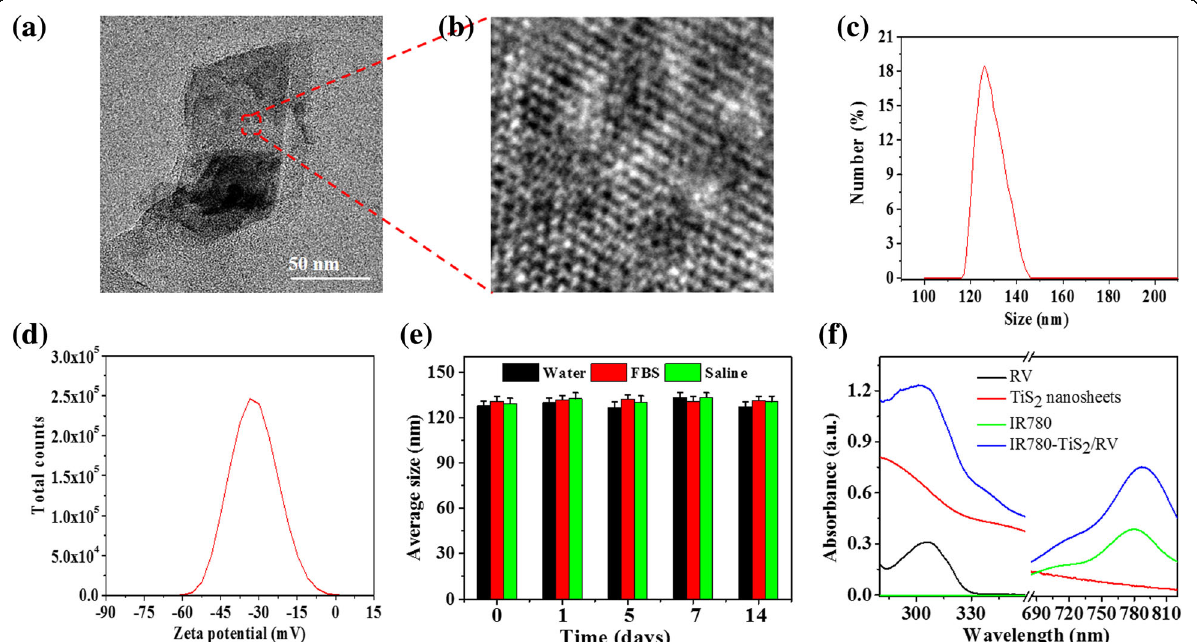
Fig. 1 a The TEM image of IR780-TiS 2 /RV. b The high-resolution TEM image of IR780-TiS 2 /RV. c The size distribution and d zeta potential distribution of IR780-TiS 2 /RV. e The hydrodynamic particle size change of IR780-TiS 2 /RV in water, FBS, and saline over 2 weeks. f The absorption spectra of RV, IR780, TiS 2 nanosheets, and IR780-TiS 2